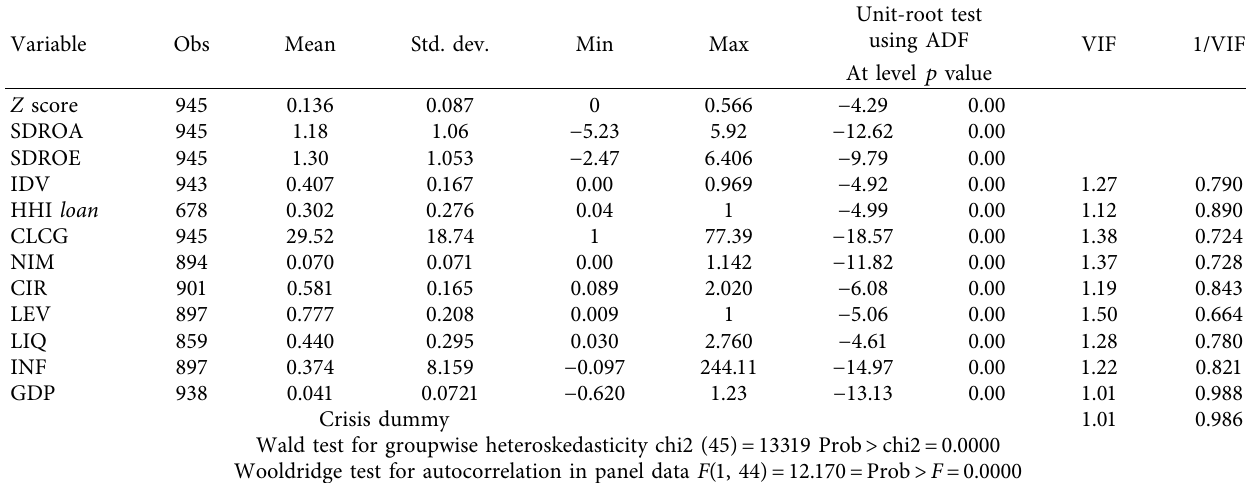
Table 3: Descriptive statistics and model diagnostic